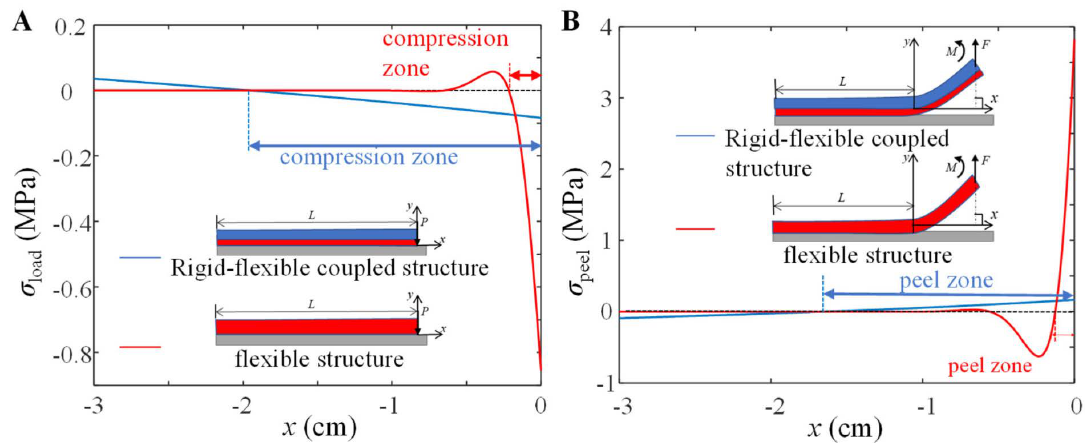
Figure 9. Numerical simulation results of the normal stress distribution of the rigid-flexible coupling adhesive unit and the flexible adhesive unit during the ( A ) compression process and ( B ) peeling process. The geometric parameters are taken as h b = 0.2 mm, h a = 3.4 mm, and L = 30 mm; the modulus of elasticity of the flexible adhesion unit is taken as 3 MPa, the normal force F = 10 N, and the peeling angle θ = 90 ◦